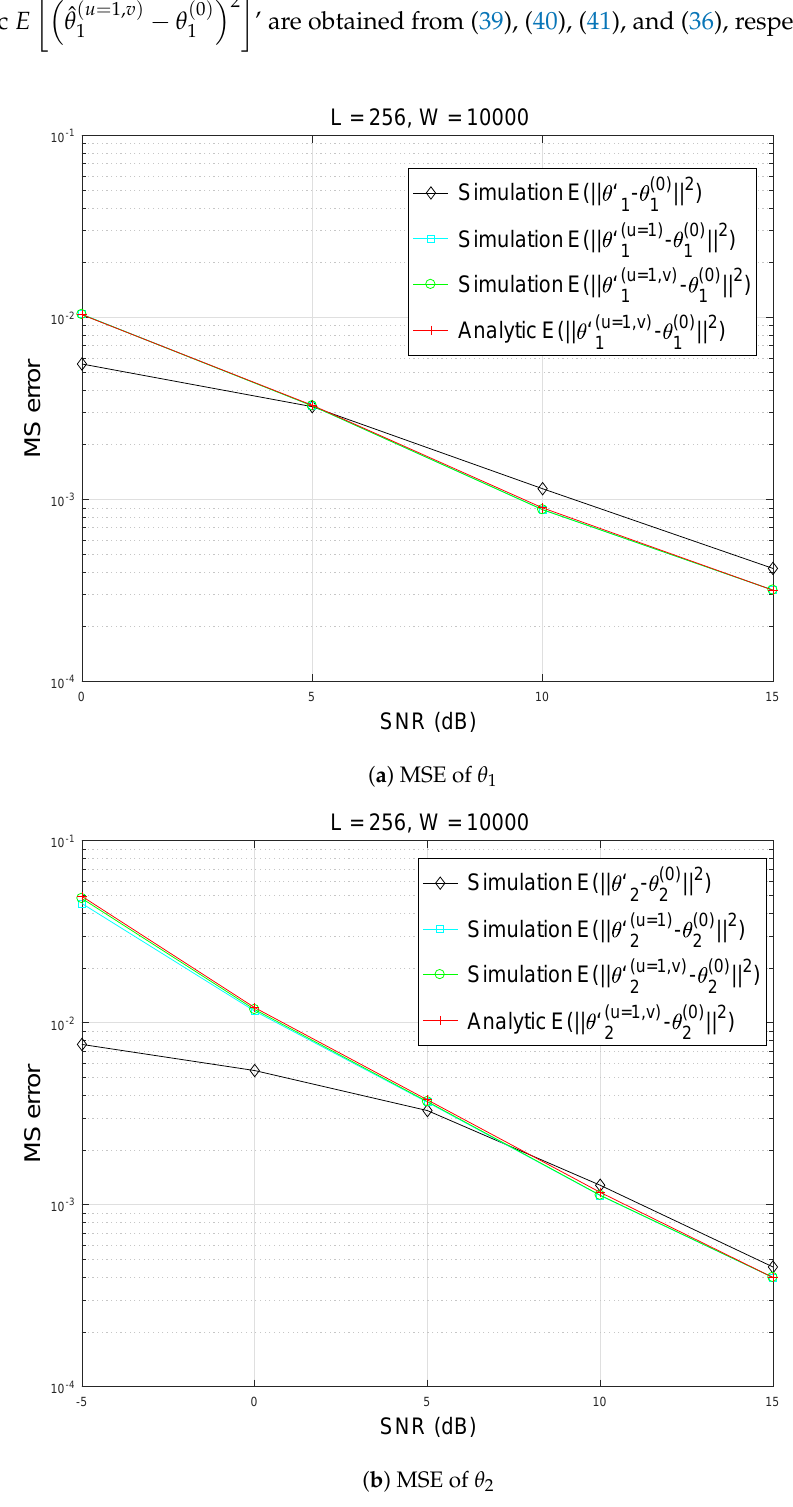
Figure 1. Analytic and simulated MSEs (Mean Square Errors) of θ 1 and θ 2 with respect to SNR (Signal to Noise